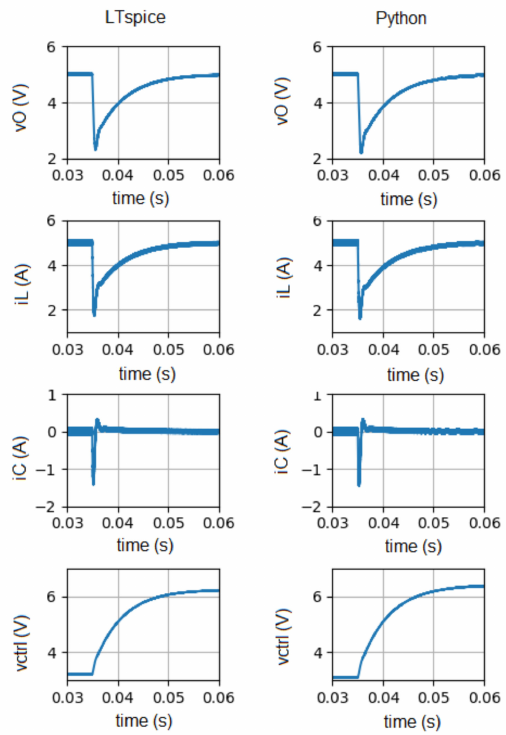
Figure 14. Waveforms of v O , i L , i C and v ctrl obtained during an input voltage variation (from 19 V to 9 V) at 35 ms, with LTspice ( left plots ) and with the proposed simulation technique ( right plots